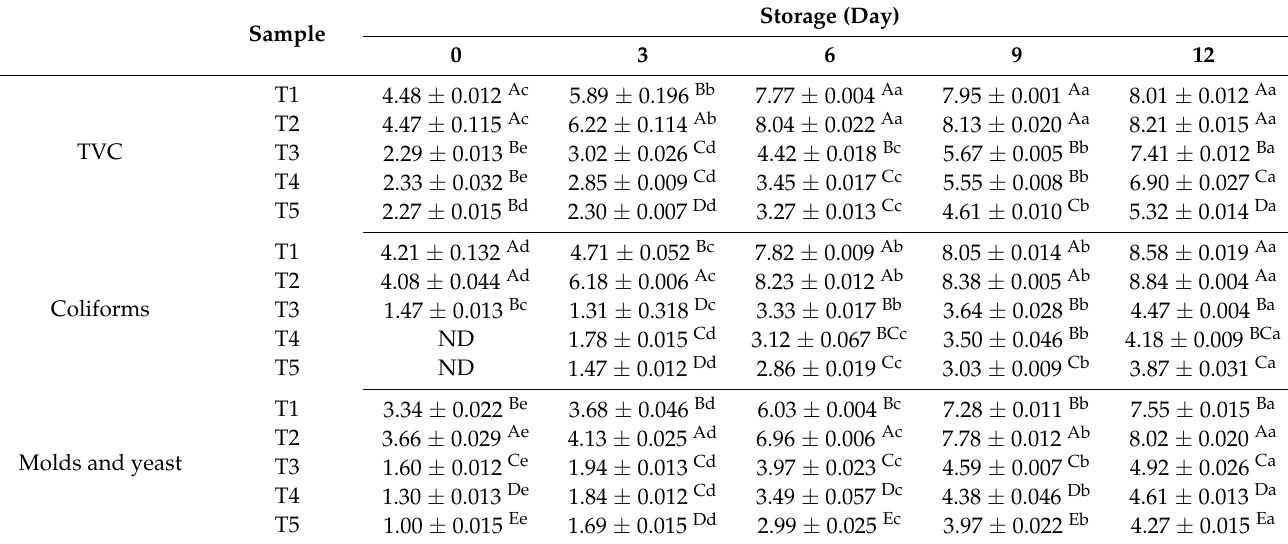
Table 5. Evaluation of microbiological counts (Log CFU/g) in chicken meat coated with chitosan containing AFEOs during storage at 4 ◦